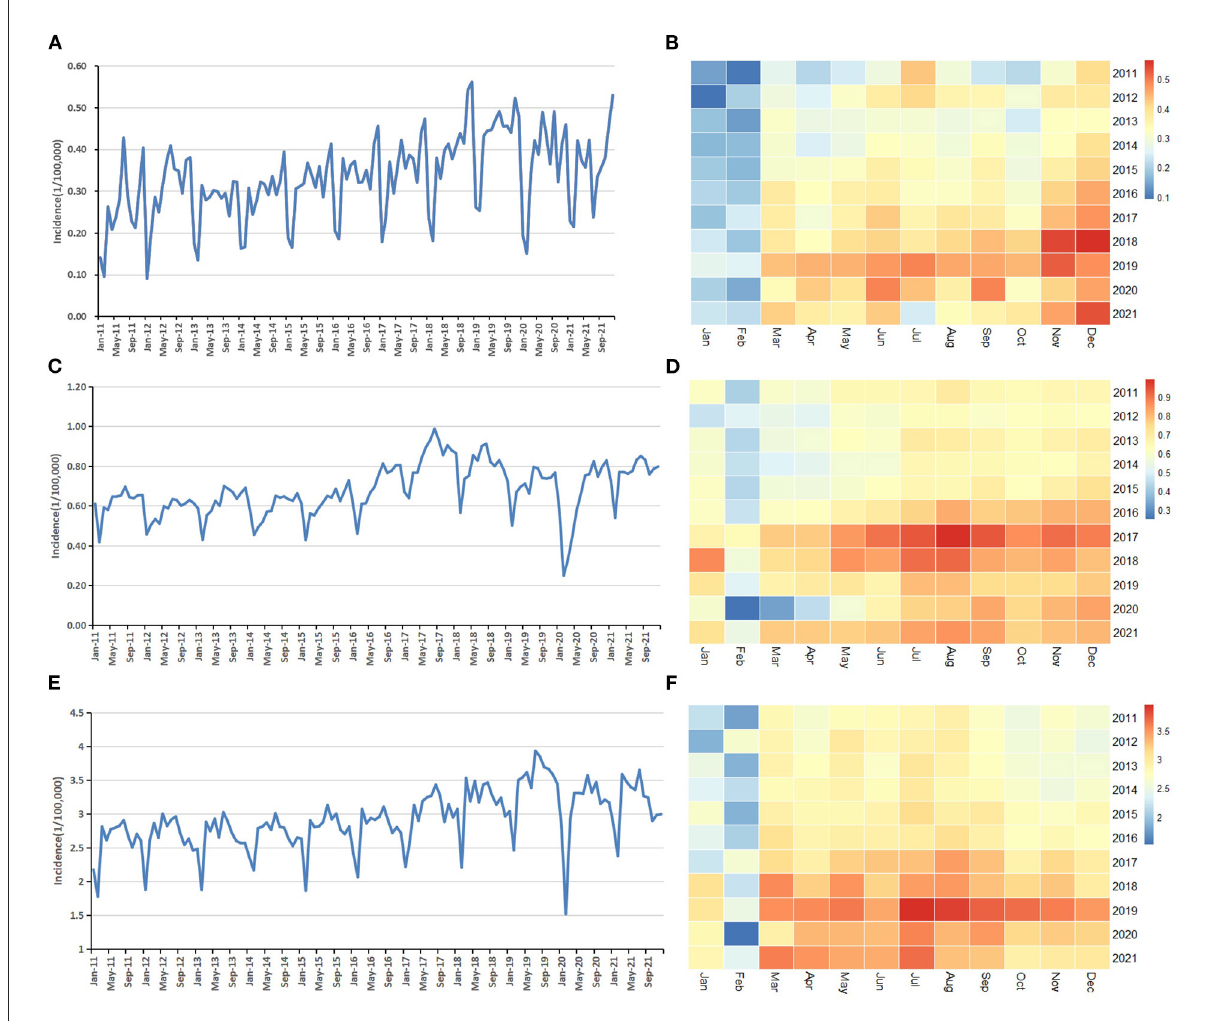
FIGURE1 Descriptive analysis of monthly reported incidence of the three STDs: (A) Trend chart of AIDS; (B) Heat map of AIDS; (C) Trend chart of gonorrhea; (D) Heat map of gonorrhea. (E) Trend chart of syphilis; (F) Heat map of syphilis.